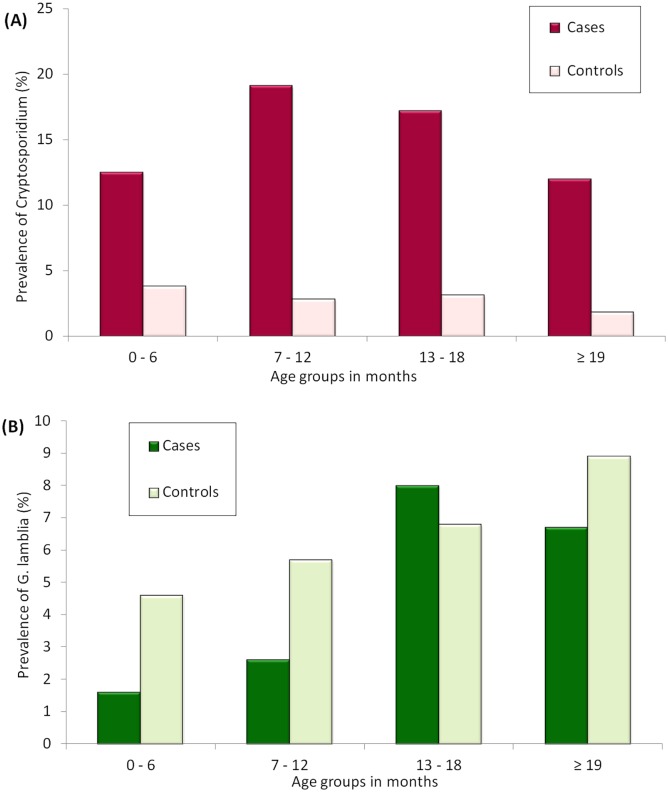
Prevalence of Cryptosporidium and G. lamblia for the different age groups.The graph shows the prevalence of (A) Cryptosporidium infection and (B) G. lamblia infection for the different age groups.